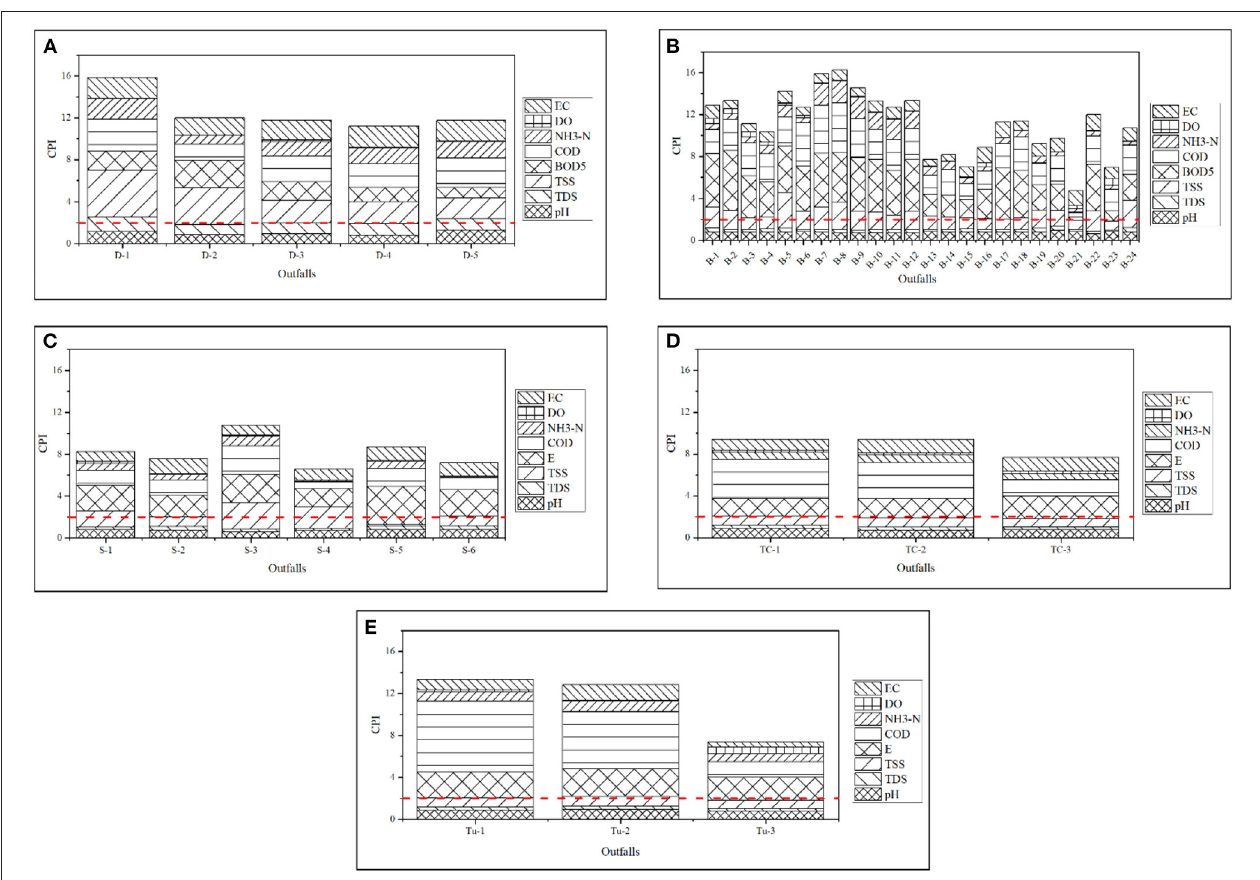
FIGURE 6 | (A–E) Assessment of CPI for the outfalls in (A) Dhaleshwari River, (B) Buriganga River, (C) Shitalakshya River, (D) Tongi Canal, and (E) Turag River (dotted lines indicate a severely polluted category of